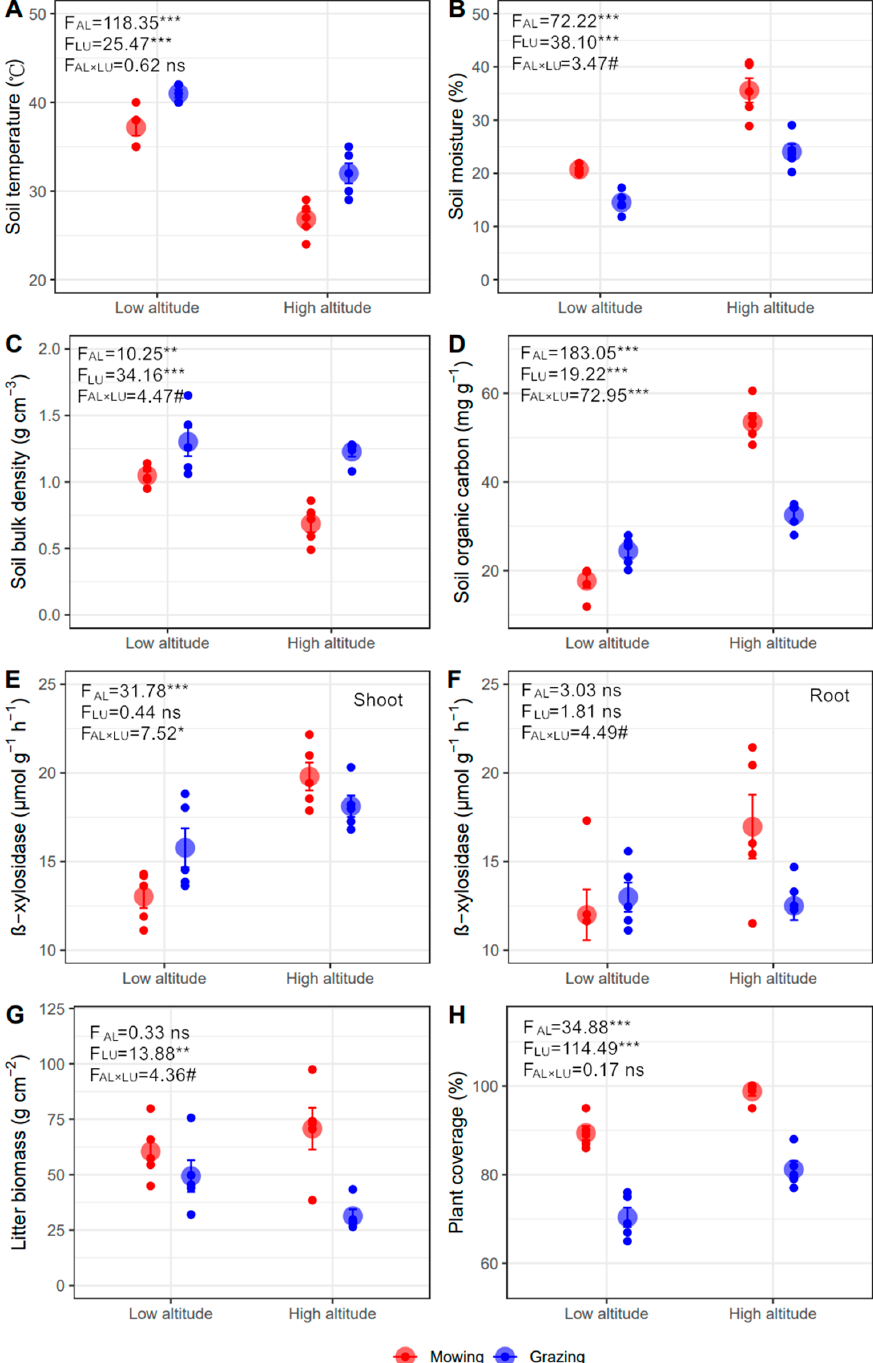
Figure 2. Soil and plant properties under different land-use types at two altitudes (mean ± SE). ( A ) soil temperature, ( B ) soil moisture, ( C ) soil bulk density, ( D ) soil organic carbon (SOC), ( E ) β -xylosidase of shoot litter, ( F ) β -xylosidase of root litter, ( G ) plant coverage, and ( H ) litter biomass. The ns, #, *, **, and *** represent p > 0.1, p < 0.1, p < 0.05, p < 0.01, and p < 0.001. Plant communities in mowing plots showed more litter and aboveground biomass compared with grazing plots ( p < 0.01, Figures 2H and S2B), and this difference was stronger at higher than lower altitudes ( p < 0.05, Figures 2H and S2B). Litter and above- ground biomass de c lined with the increasing altitude in grazing, while the opposite